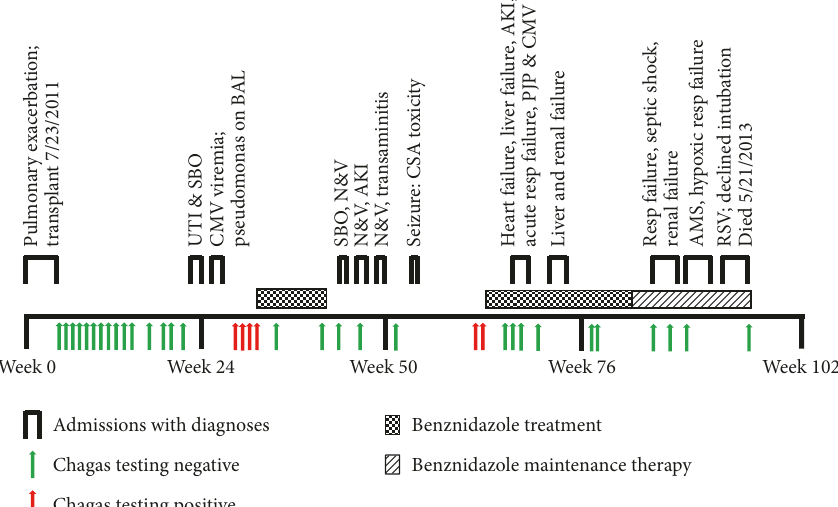
Figure 1: Time course of Chagas reoccurrences and complications after transplant. While it is unlikely that the patient would have survived his admission for respiratory failure without a transplant, a significant portion of this posttransplant life was marred by both T. cruzi detected in the blood and hospitalizations for various causes. Urinary tract infection (UTI), small bowel obstruction (SBO), bronchial alveolar lavage (BAL), acute kidney injury (AKI), cyclosporine (CSA), nausea & vomiting (N&V), Pneumocystis jiroveci pneumonia (PJP), respiratory failure (resp failure), altered mental status (AMS), and respiratory syncytial virus